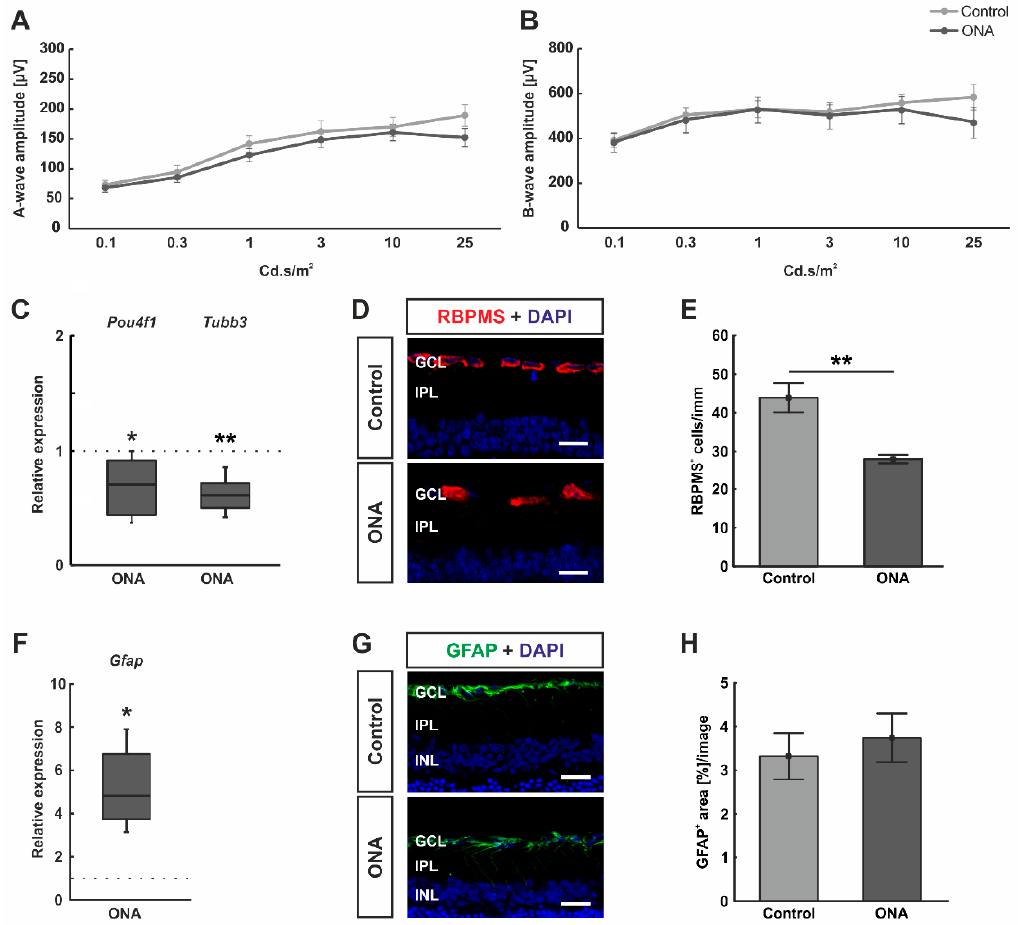
Figure 2. No functional alteration, but loss of retinal ganglion cells after immunization. ( A ) Electro- physiological analyses were performed 28 days after ONA immunization. The response of the photoreceptors is depicted as the a-wave amplitude. At all measured light intensities, the a-wave amplitudes did not differ between ONA and control animals. ( B ) In addition, the b-wave amplitudes, which reflect the response of the inner nuclear cells, were not altered in ONA retinae compared to control ones at all light intensities. ( C ) RT-qPCR analyses revealed a significant downregulation of Pou4f1 ( p = 0.036) and Tubb3 mRNA expression levels ( p = 0.006) in ONA rats. ( D ) RGCs were la- belled against anti-RBPMS (red) and cell nuclei were counterstained with DAPI (blue). ( E ) The num- ber of RGCs were significantly decreased in ONA animals compared to controls ( p = 0.004). ( F ) Gfap mRNA expression levels were significantly upregulated after ONA immunization ( p = 0.027). ( G ) Retinal cross-sections were stained against anti-GFAP (astrocytes; green) and DAPI (cell nuclei; blue). ( H ) The GFAP + staining area was not altered between ONA and control animals. Scale bars: 20 µm. GCL = ganglion cell layer; IPL = inner plexiform layer; INL = inner nuclear layer. Values for RT-qPCR are median ± quartile ± minimum/maximum and values for ERG and immunofluores- cence are mean ± SEM. The dotted lines in ( C , F ) represent the relative expression of the control group. * p < 0.05, ** p < 0.01.